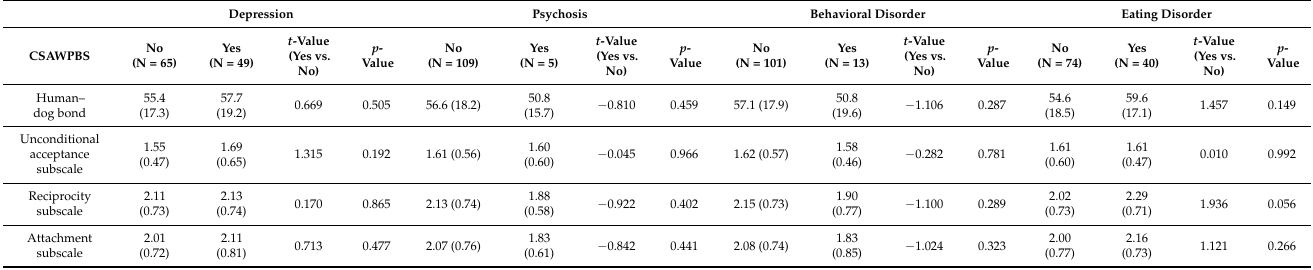
Table 4. Participant–dog bond according to